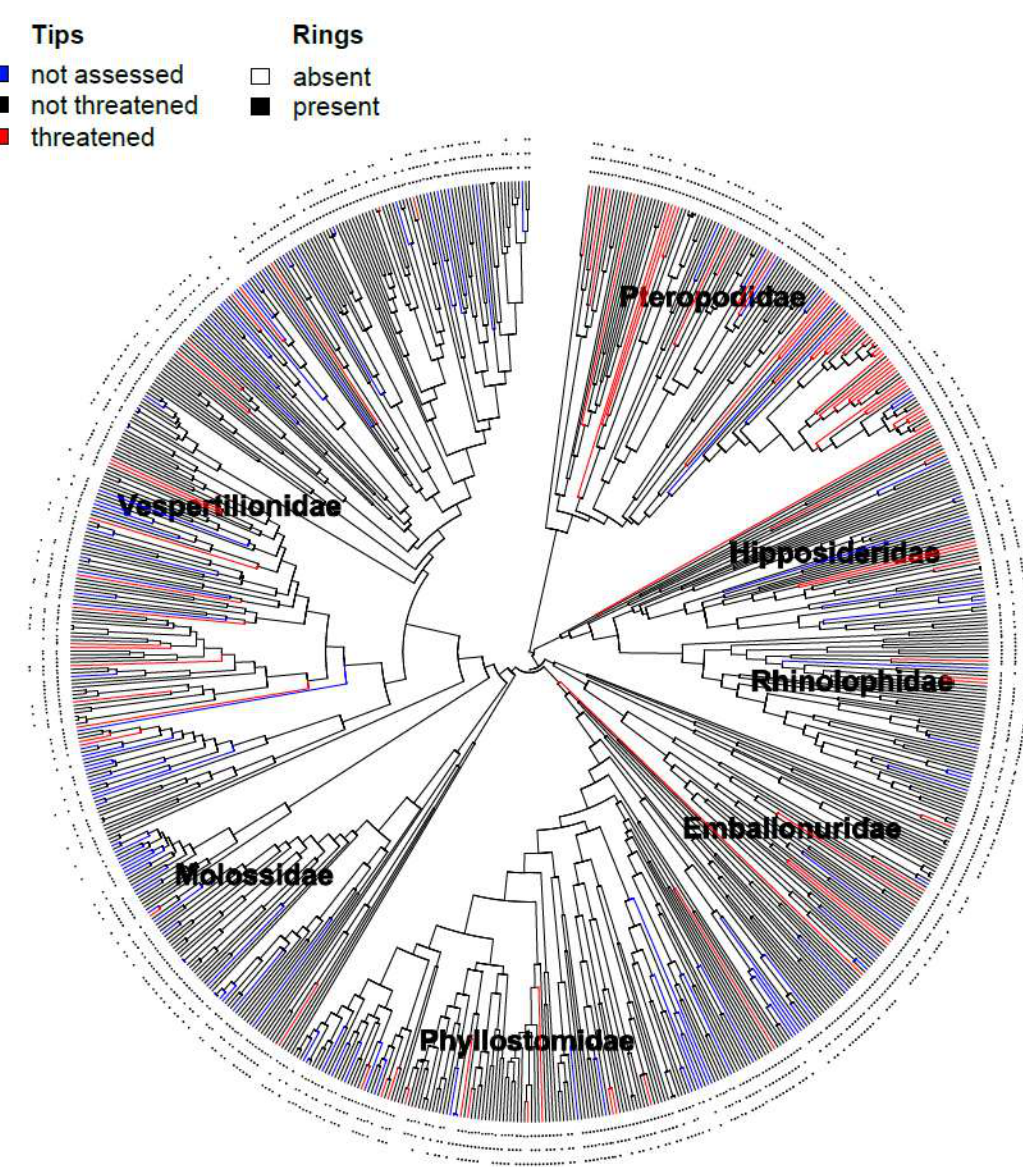
Figure 1. The dated phylogenetic tree of bats (excluding the outgroup) based on five genes available through GenBank (see main text). Several bat families are highlighted. The color of the tree tips represents a species’ IUCN binary risk assessment. Data availability is shown by the rings surrounding the tips, which represent individual species, and refer to the following variables (starting at the inner-most ring): 1 = range and endemism, 2 = body mass, 3 = diet breadth and trophic level.